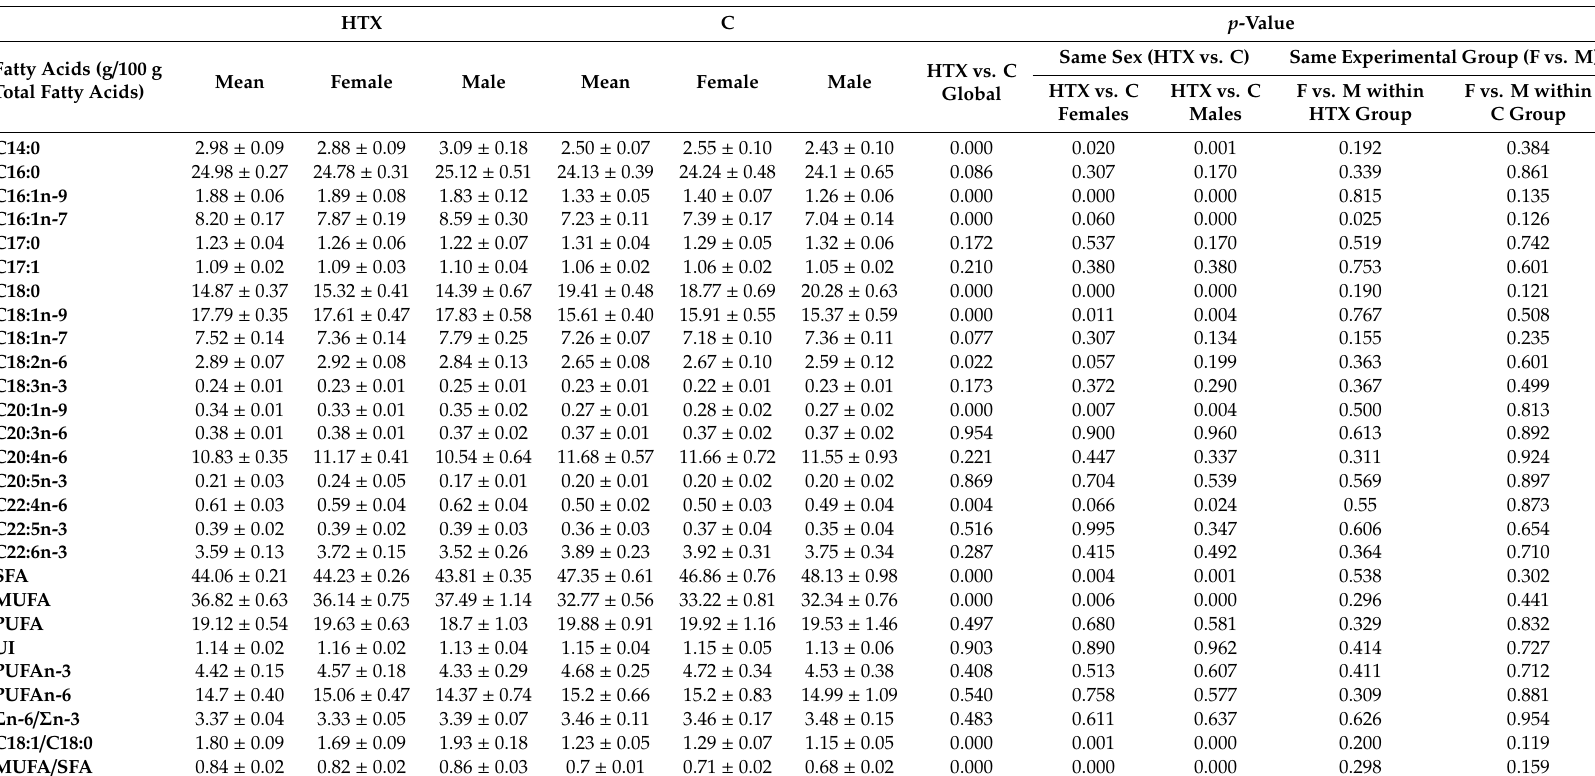
Table 2. E ff ects and di ff erences between sexes, of maternal hydroxytyrosol supplementation on the fatty acid profile of the fetal liver. Mean values ( ± SEM) of neutral lipids in female (F) and male (M) fetuses of the treated (HTX) and the control group (C). HTX C p -Value Fatty Acids (g / 100 g Mean Female Male Mean Female Male Total Fatty Acids)